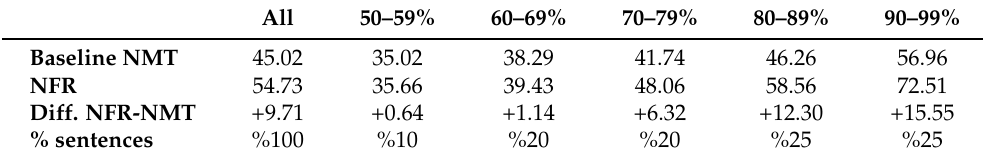
Table A2. BLEU scores for the baseline NMT and the NFR system for the subset used for manual evaluation, as well as the difference between the BLEU scores obtained by the baseline and NFR systems. % sentences shows the percentage of sentences that make up the different subsets.